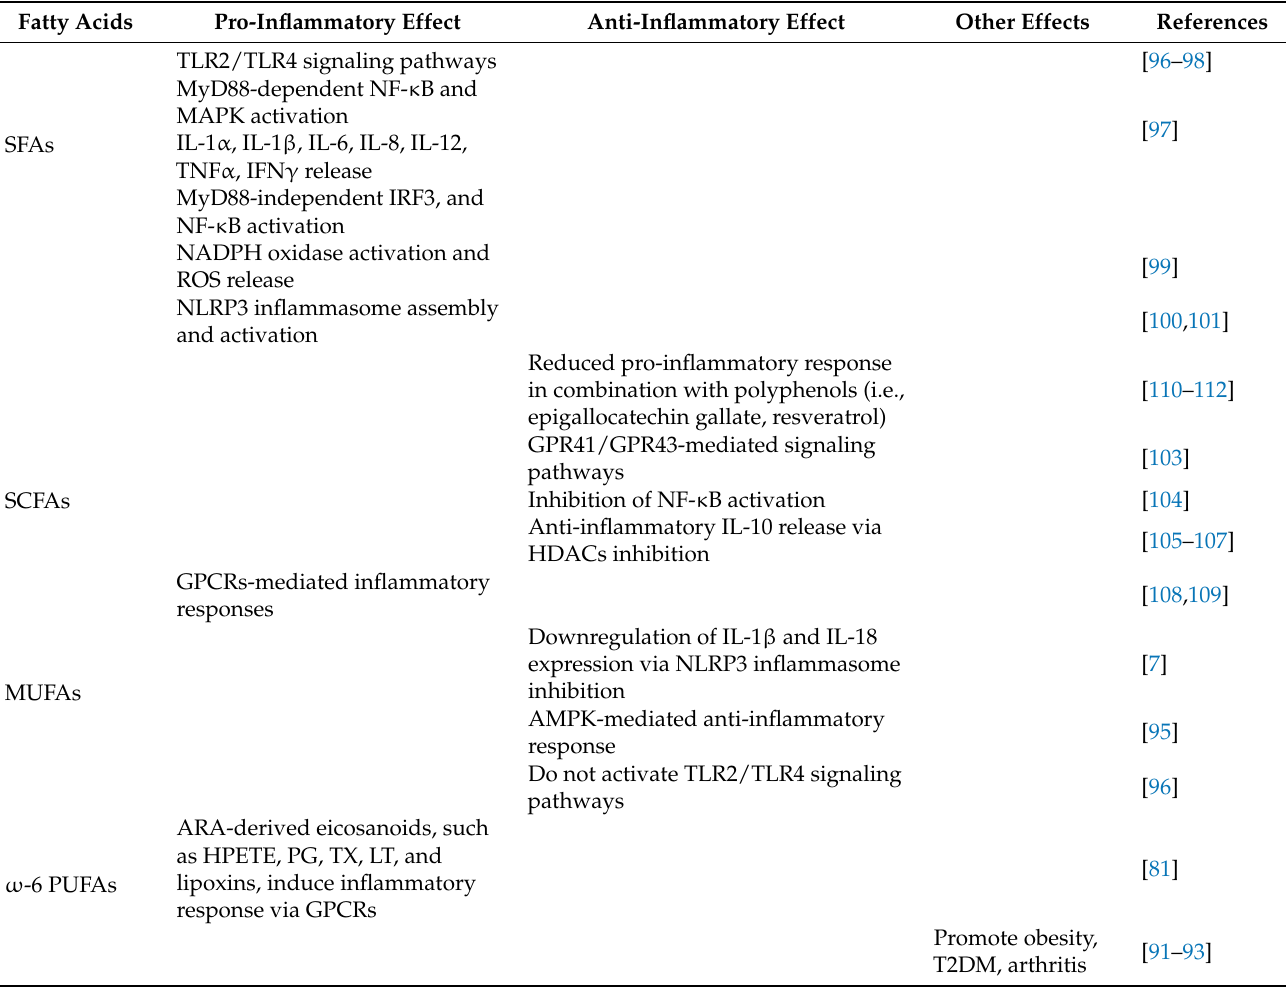
Table 1. Major molecular mechanisms explaining the dietary FAs modulation of the inflammatory response. Fatty Acids Pro-Inflammatory